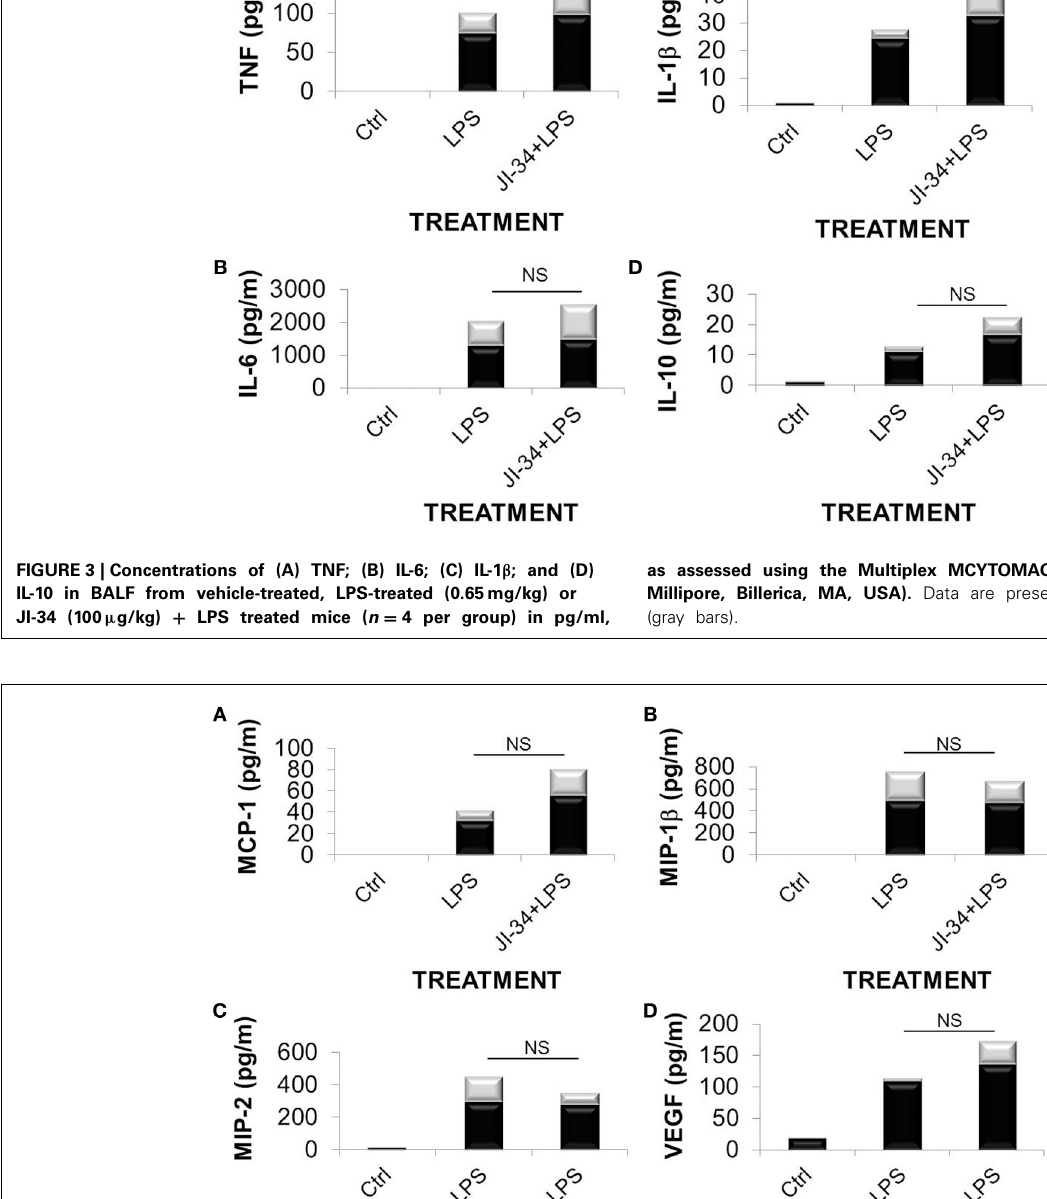
FIGURE 4 | Concentrations of the chemokines (A) MCP-1; (B) MIP-1 β ; (C) MIP-2; and the growth factor (D). VEGF in BALF from vehicle-treated, LPS-treated or JI-34 + LPS treated mice ( n = 4 per